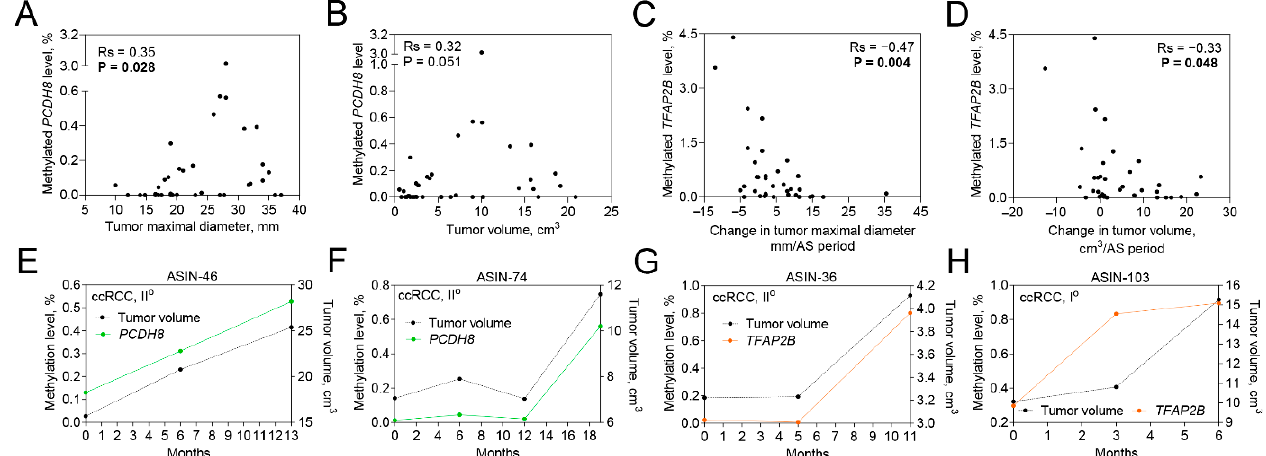
Figure 3. The association of investigated biomarkers with SRM size and growth rate. ( A , B ) Correlation between methylated PCDH8 level and SRM size at diagnosis. ( C , D ) Correlation between methylated TFAP2B level and change in tumor size during AS period. ( E – H ) Associations between individual tumor growth dynamics and methylated PCDH8 and TFAP2B levels. Rs—Spearman correlation coefficient; AS—active surveillance; ccRCC—clear cell renal cell carcinoma. ASIN depicts the patient’s ID. Significant p -values are in bold.